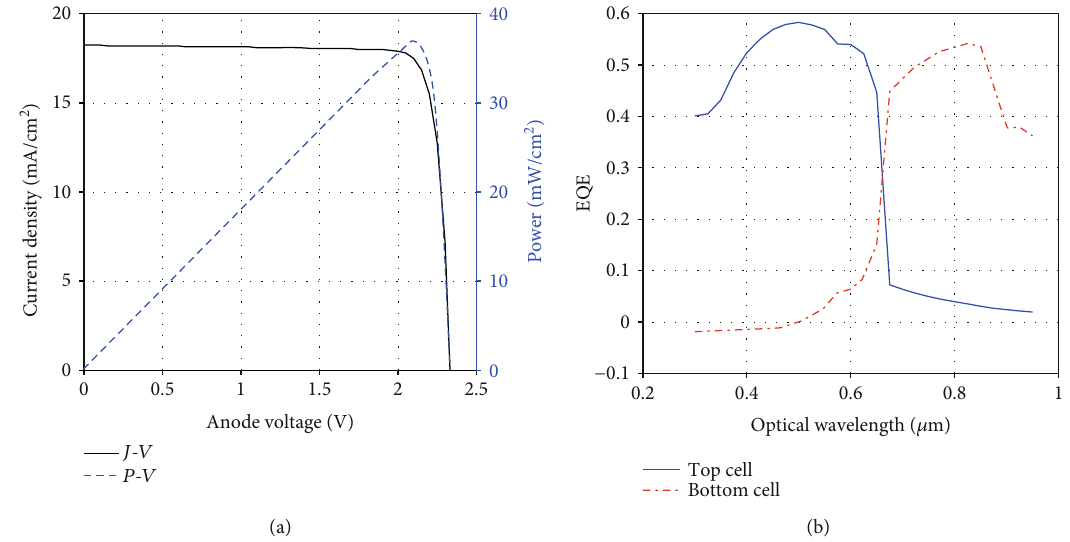
Figure 6: Simulation results of the optimized DJ solar cell using Al